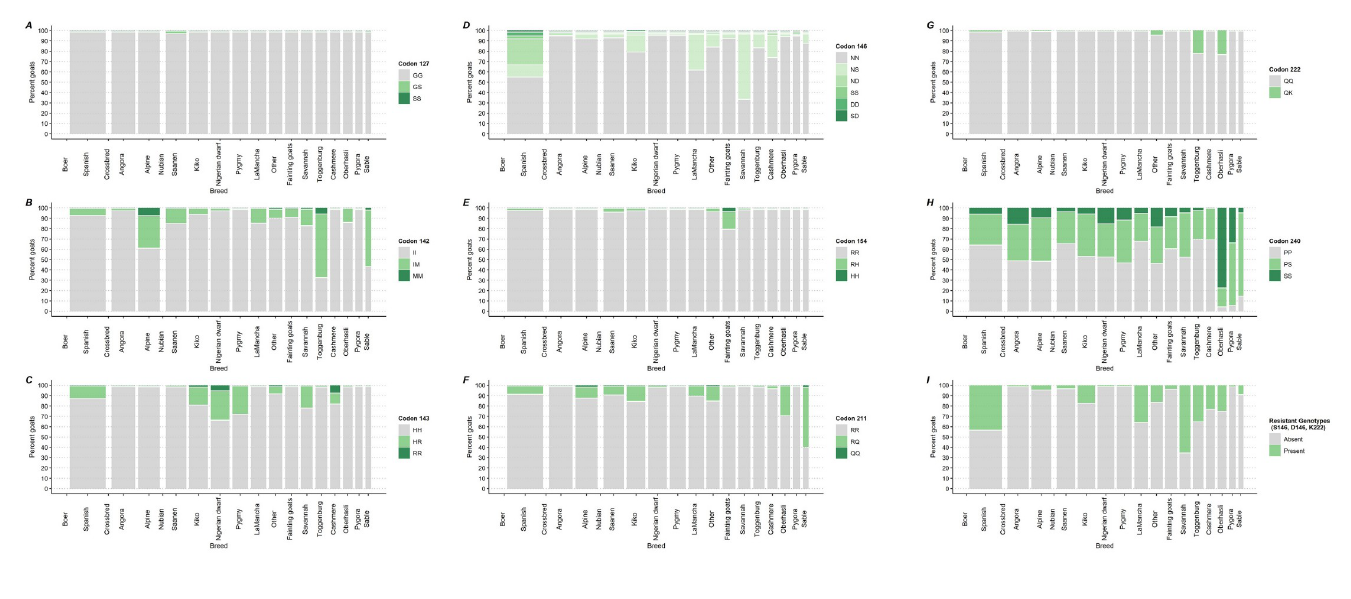
Fig 6. Percentage of goats by caprine PRNP polymorphic variants at codons 127, 142, 143, 146, 154, 211, 222 and 240 by goat breed (widths of bars are taken to be the cubed roots of the weighted frequencies of goats by breed).